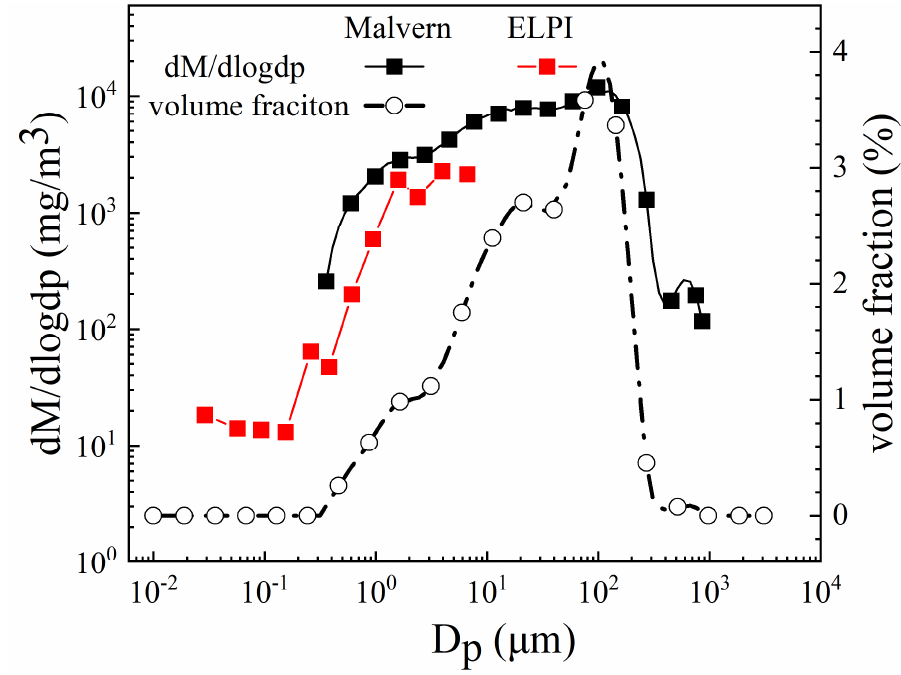
Figure 3. Fly ash particle mass concentration distribution at the dust collector’s inlet and particle Figure 3. size distribution.